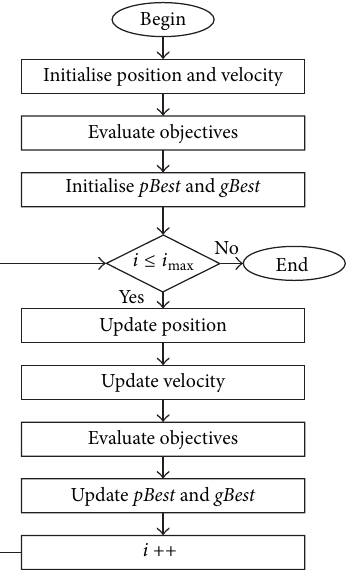
Figure 2: The PSO